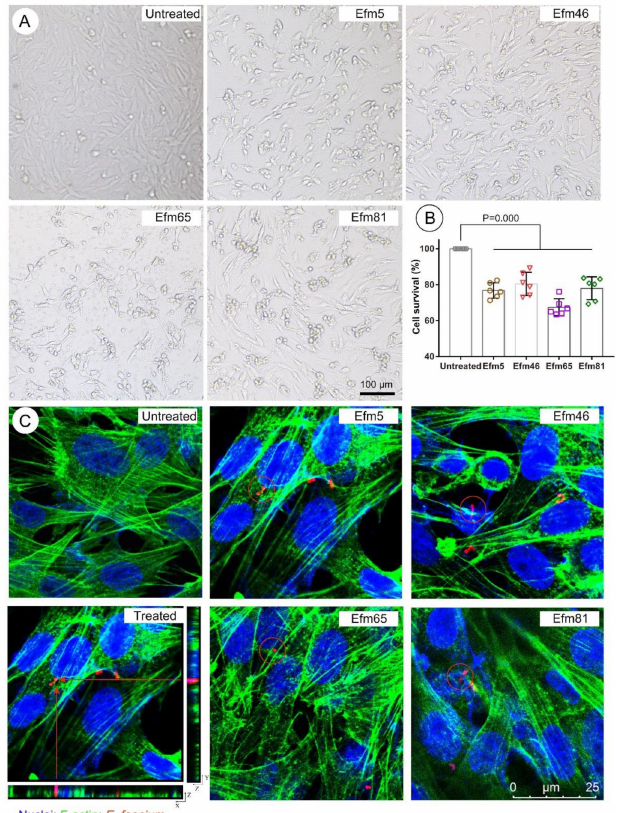
Figure 4. Toxicity evaluation of probiotic enterococcal isolates in vitro. ( A ) The morphology of human intestinal epithelial cells (HIEC cells) in different treated groups. Scale bar = 100 µ m. ( B ) Rates of cell survival in different treated groups. ( C ) Probiotic enterococcal isolates internalization in human intestinal epithelial cells. F-actin was stained by GFP (green) and nuclei were counter- stained with DAPI (blue). Enterococcal isolates were stained by rhodamine-phalloidin (red). Red arrows: Internalized bacteria in a 3D image. Red circles: Internalized bacteria. Scale bar = 25 µ m. Differences in B were assessed by one-way ANOVA, and the values are presented as the mean ± SD. p ≤ 0.05 was considered to be